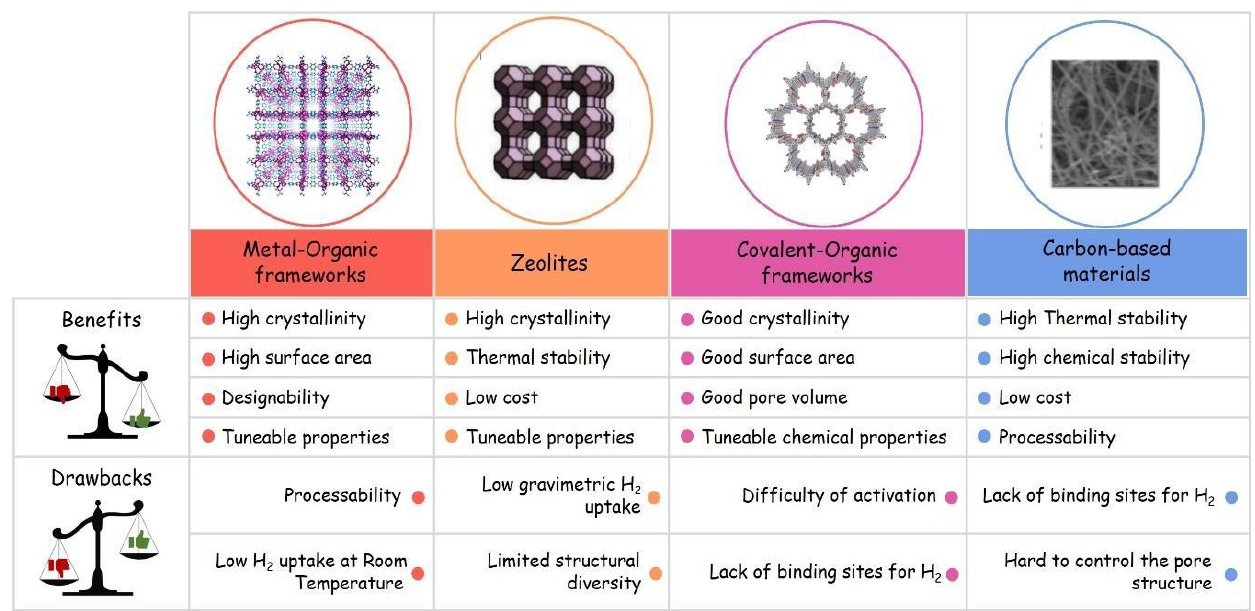
Figure 4. Summary of benefits and drawbacks of the main sorbent systems for hydrogen storage.